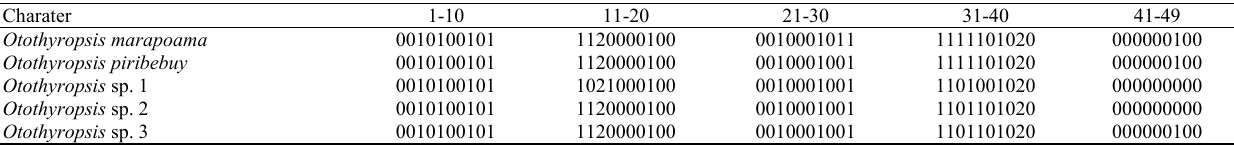
Table 1. Character states of Otothyropsis species for the 49 character matrix compilation from Schaefer (1998) and Ribeiro et al .